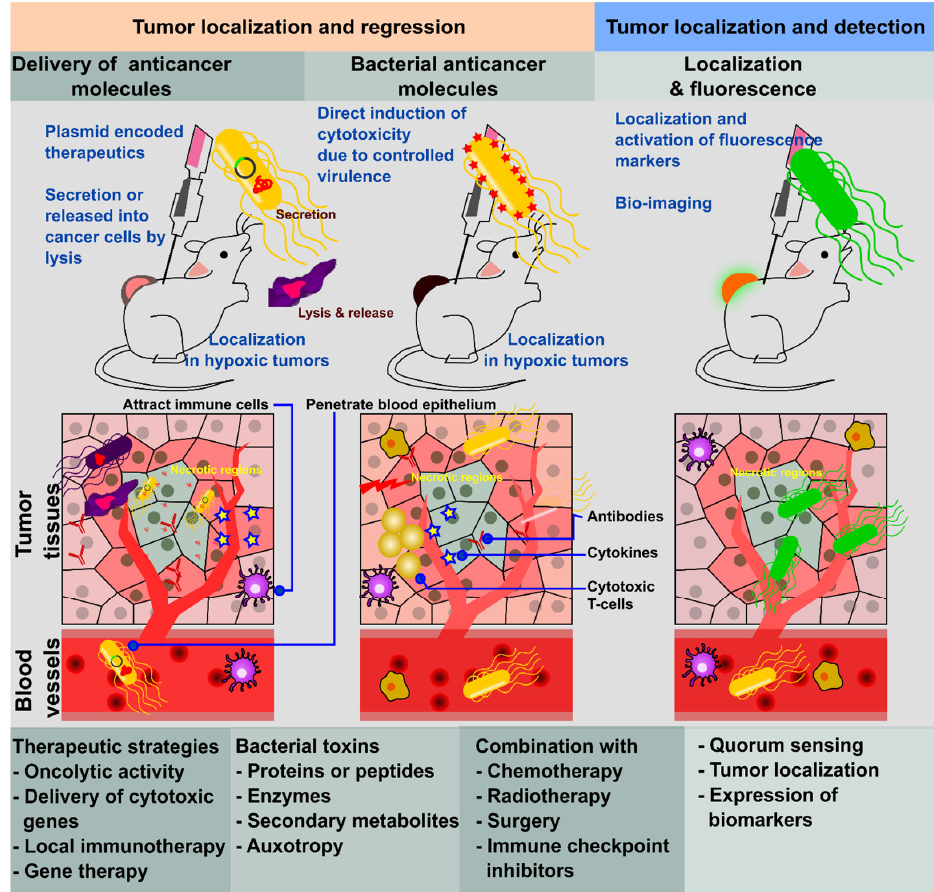
Figure 1. Therapeutic strategy for Salmonella -mediated cancer therapy. Salmonella has been exploited to localize and regress tumors via the delivery of anti-cancer molecules to induce cytotoxicity. The intrinsic tumor-targeting feature of Salmonella has been hijacked to deliver the gene of interest or secondary metabolites to suppress the tumor. Recently, combination therapy with conventional treatment strategies is more effective in the treatment of various cancers. Another promising approach is the bio-imaging of the tumor by using a fluorescence marker that enhances the localization and helps in targeting the metastatic